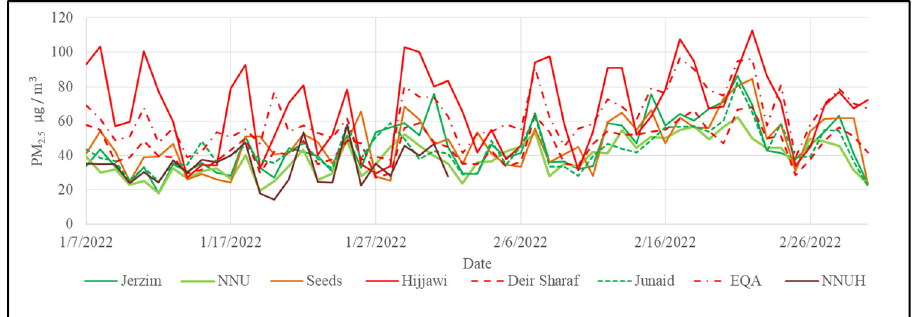
Figure 6. Average daily PM 2 . 5 concentration in each measuring site.